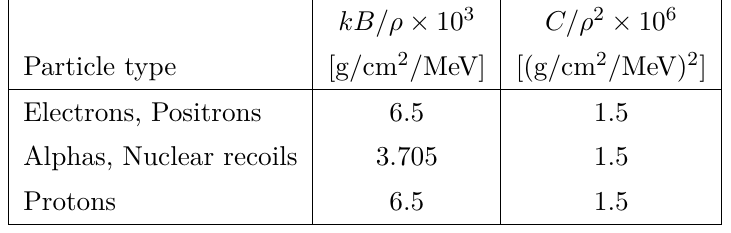
Table 2. Values of the Birks’ coefficients of equation (4.1) divided by the LS density ρ ( ρ = 0 . 86 g/cm 3 ) used to compute the ionization quenching in JUNO